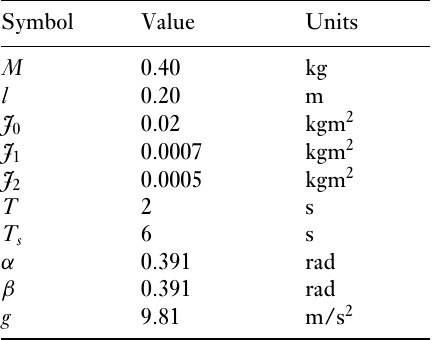
Table 3 Biped robot parameters